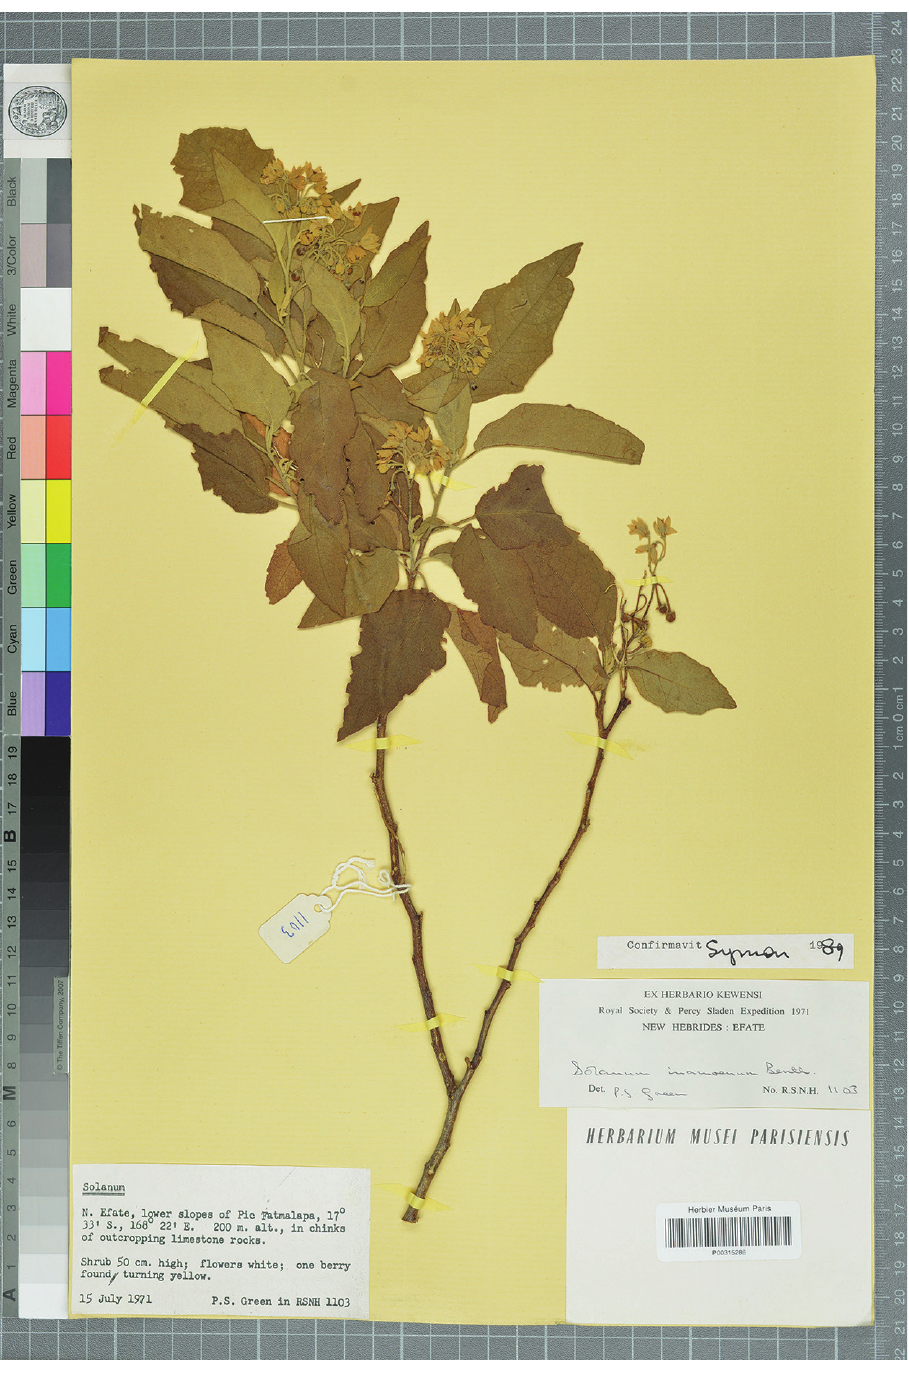
Figure 12. Solanum vanuatuense D.McClelland (holotype Green 1103 , P [P00315286]). Reproduced with